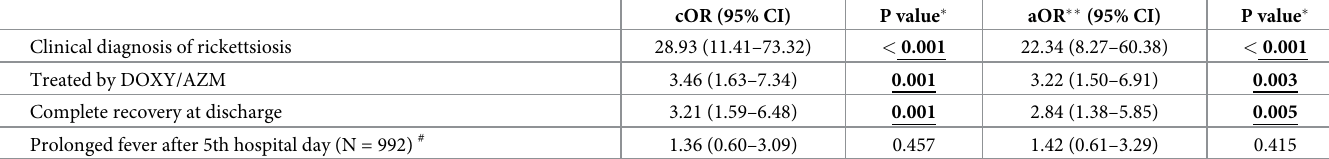
� P values were calculated by univariable logistic regression analysis for crude odds ratios and multivariable logistic regression analysis for adjusted odds ratios. �� Adjusted for age > 50, gender, living by farming, living outside of Hanoi, and having a comorbidity. # Missing values were imputed by multiple imputation using multivariate normal regression models including all the variables with missing values, age, gender, living by farming, living outside of Hanoi, having a comorbidity, and ST